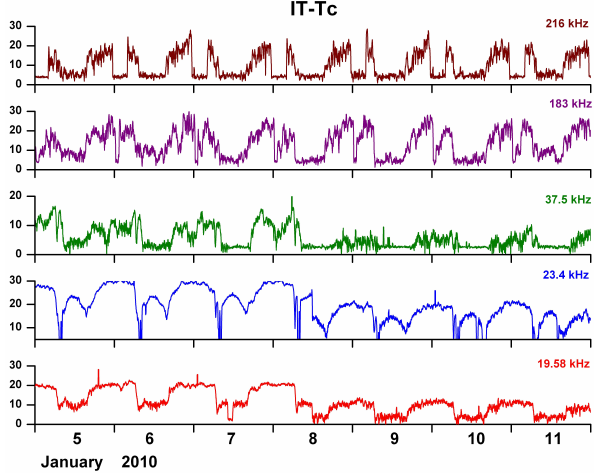
Fig. 10. The three upper panels represent the air temperature, air pressure and rainfall in Bari in the time interval 9–18 October 2009. The remaining panels show the trends of the intensity of CZE (270kHz) and TRT (183kHz) LF radio signals and of ICV (20.27kHz) and GBZ (19.58kHz) VLF radio signals collected by IT-Tc receiver during the same period. A decrease/disturbance of the radio intensities appears during 13–14 October when an abrupt decrease of the air temperature, a large decrease of the air pressure and rain